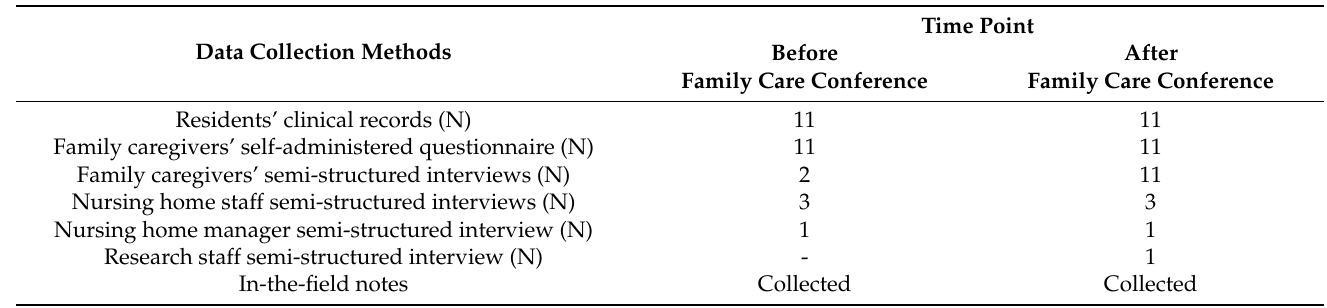
Table 2. Data Collection Summary with Time Points.